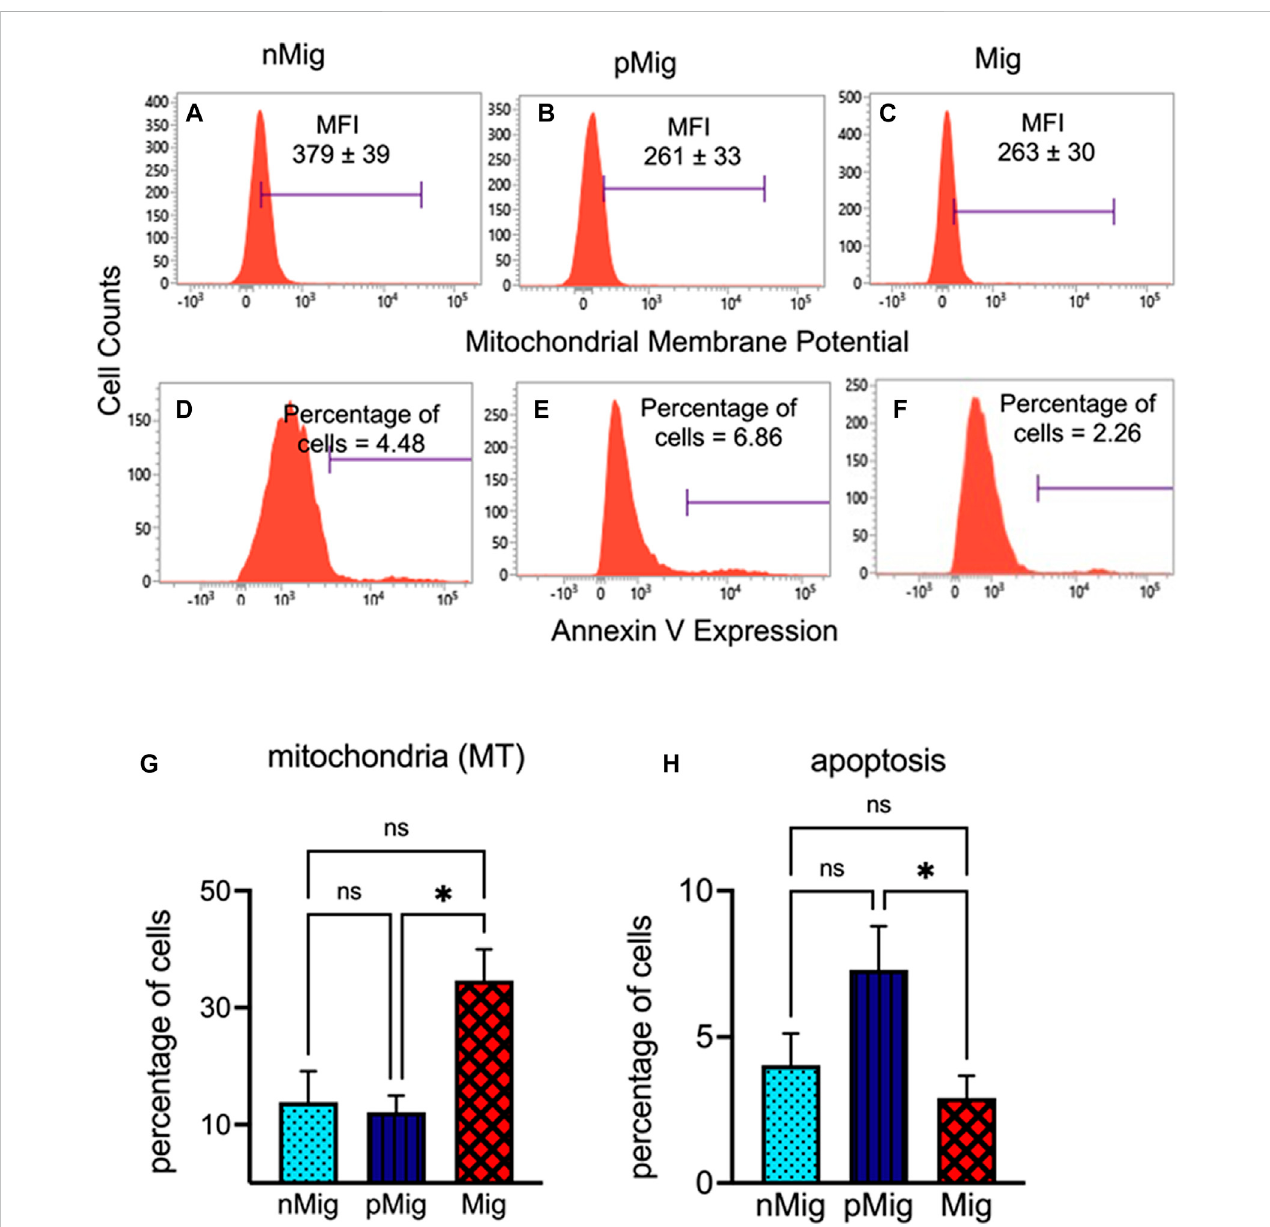
FIGURE 4 Alteration in the mitochondrial membrane potential (MMP) and apoptosis in erythrocytes in circulation. The blood was collected from non-migratory ( nMig , cyan blue), pre-migratory ( pMig , blue), and migratory ( Mig , red) red-headed buntings ( n = 6) placed under SD/LD for 0, 7, and 28 days. MMP erythrocytes were determined by staining with MitoTracker red dye. Apoptotic cells were quanti fi ed using Annexin V staining followed by fl ow cytometric analysis. Flow cytometric histograms in panels (A – C) show the MMP in nMig , pMig , and Mig states, respectively. The proportion of apoptotic cells in corresponding states has been depicted in panels (D – F) . The bar graph in panels (G,H) shows the cumulative changes in mitochondrial membrane potential and apoptotic cell proportion. The horizontal blue line inpanel (A – C) represents themean fl uorescence intensity (MFI) ofmitotracker stain. In panels (D – F) , it corresponds to the percentages of Annexin V-positive cells. Data are represented as mean ± SEM. Asterisk (*) over the line on the bar indicates a signi fi cant difference between nMig , pMig , and Mig states of buntings (* p < 0.05, Tukey ’ s